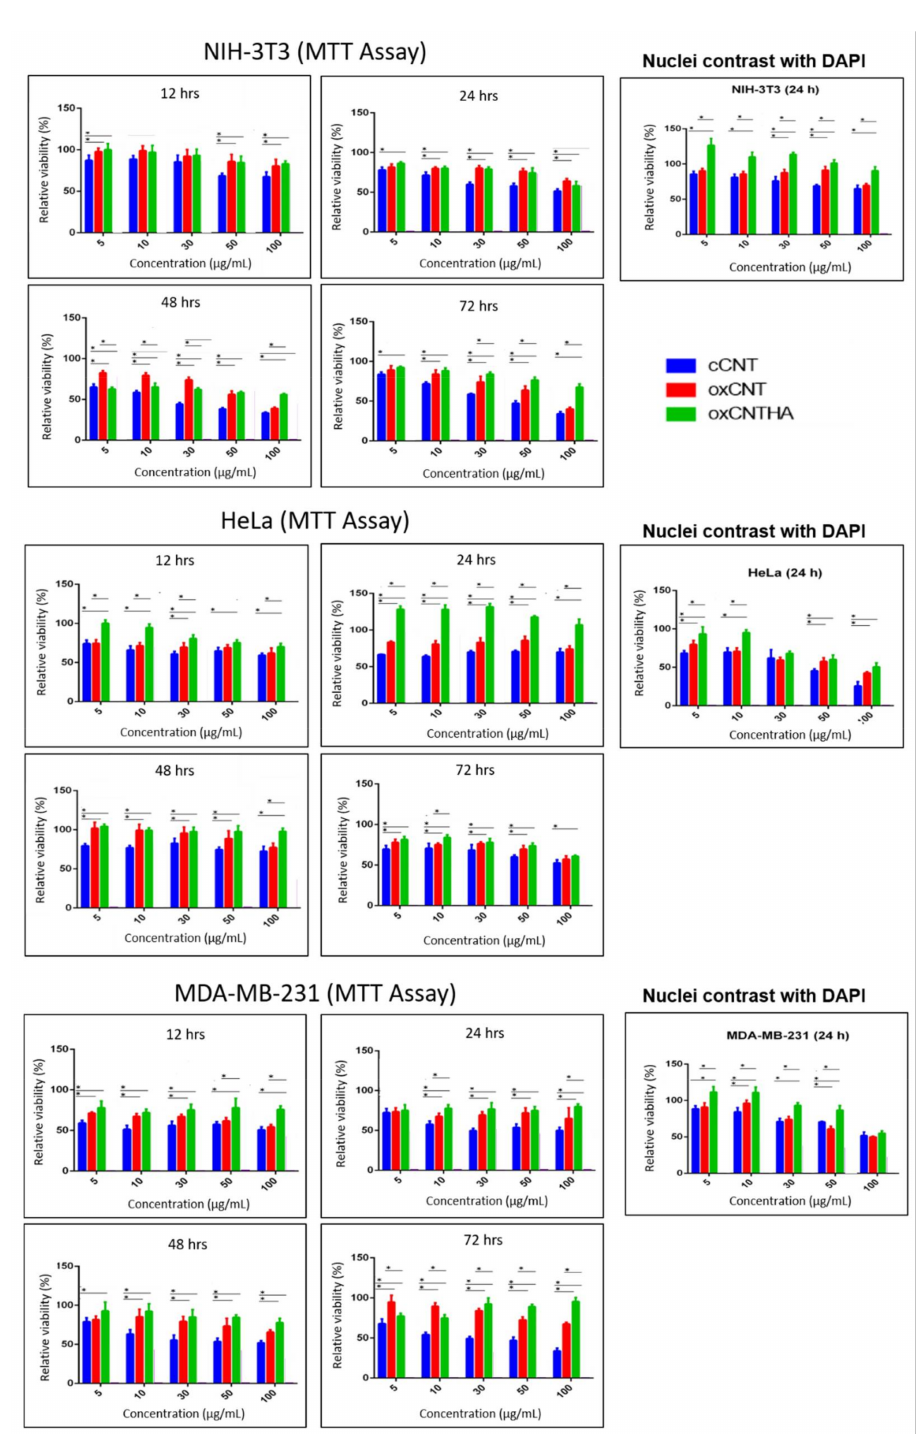
Figure 4. Graphs of the 3-(4,5-dimethylthiazol-2-yl)-2,5-diphenyltetrazolium bromide (MTT) colori- metric, and 4 (cid:48) ,6-diamidino-2-phenylindole (DAPI) assays representing viability in NIH-3T3, HeLa, and MDA-MB-231 cell lines after administration of cCNT (blue bar), oxCNT (red bar), and oxCNT-HA (green bar) at doses of 0, 5, 10, 30, 50 and 100 µ g/mL and 12, 24, 48, and 72 h. Note that oxidation and functionalization of cCNTs decrease their cytotoxicity. (n = 5). Tukey’s statistical test. P < 0.05. The asterisk (*) indicates statistical